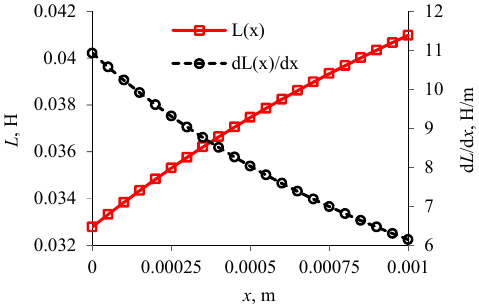
Figure 4. Calculated values of inductance and its derivative.